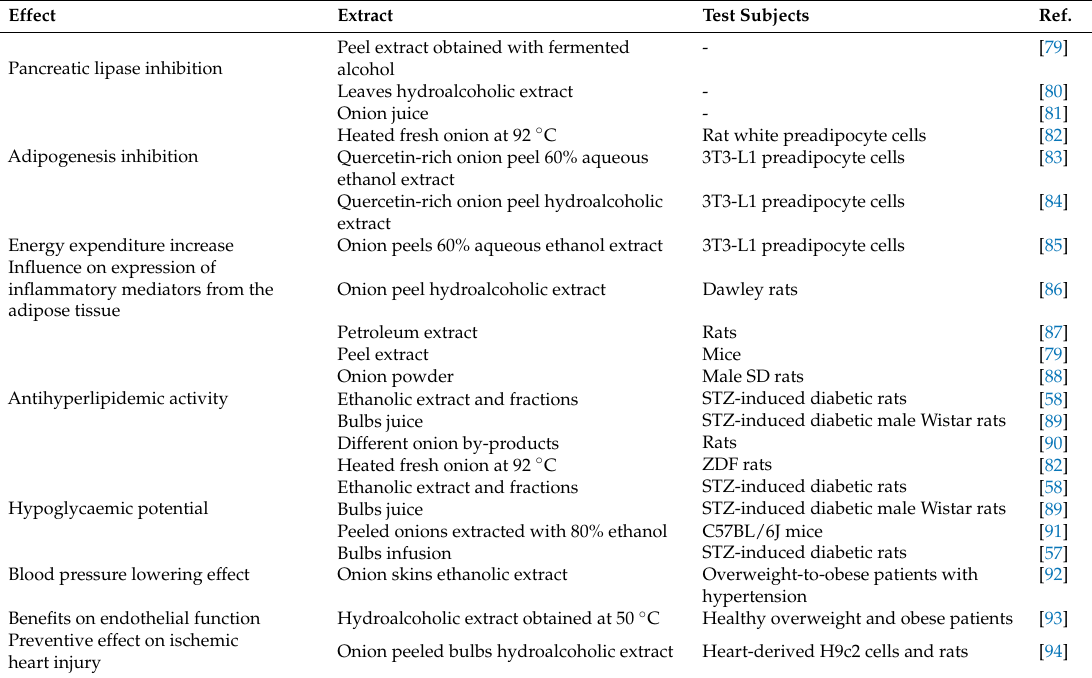
Table 1. Beneficial effects of A. cepa on obesity and related